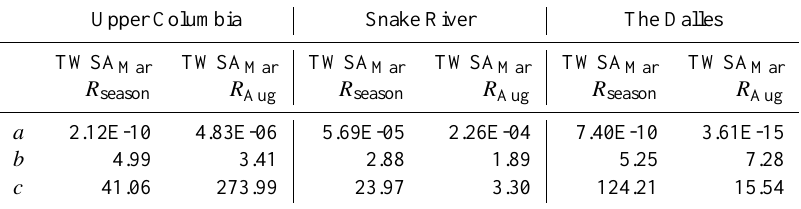
Table 3. Parameters from the power function curves in each of the three watersheds using TWSA to predict streamflow. Figure 7 provides these results